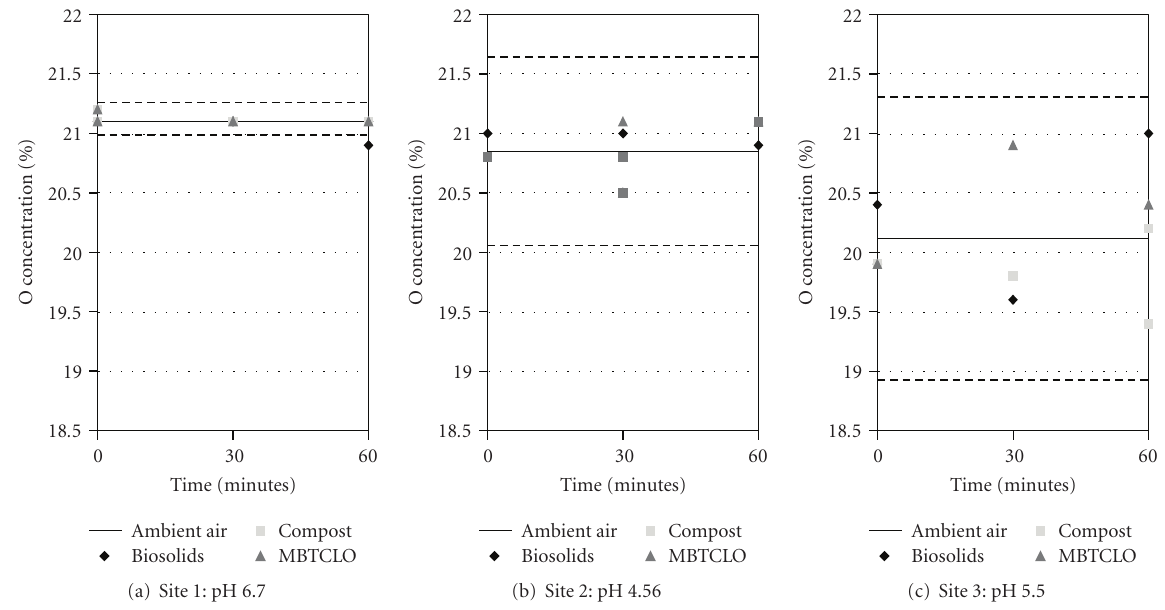
Figure 10: Oxygen concentrations measured at each site. The solid line indicates mean ambient concentration measured, and the dashed lines are 3 standard deviations from